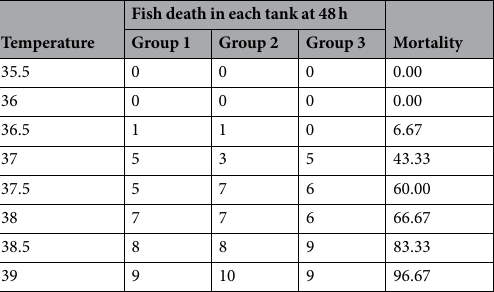
Table 1. Comparison of the cumulative mortality of GIFT at high temperature stress for 48